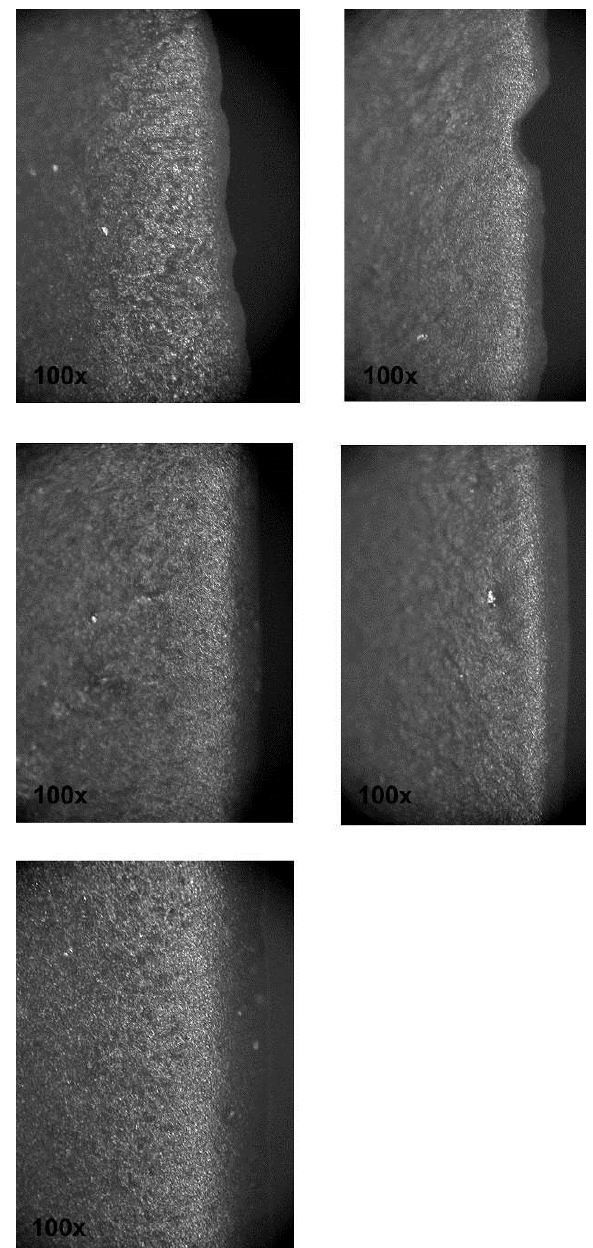
Figure 8: The experimental MUG tools after scraping dry ungulate hide for 30 minutes. The mean density of wear for BB ranged from a minimum of 0.0012 to a maximum of 0.0069 after 10 minutes, from 0.0028 to 0.0179 after 30 minutes, and from 0.0058 to 0.0111 after 60 minutes of use. The percent difference for mean density was 475% after 10 minutes, increasing to 539.3% after 30 minutes, and dropping significantly to 91.4% after 60 minutes of use. The mean average intensity for BB ranged from a minimum of 43.87 to a maximum of 57.89 after 10 minutes, from 38.08 to 43.27 after 30 minutes, and from 40.70 to 44.93 after 60 minutes of use. The percent difference for mean average intensity also decreased progressively from 32% after 10 minutes to 13.6% after 30 minutes and finally to 10.4% after 60 minutes of